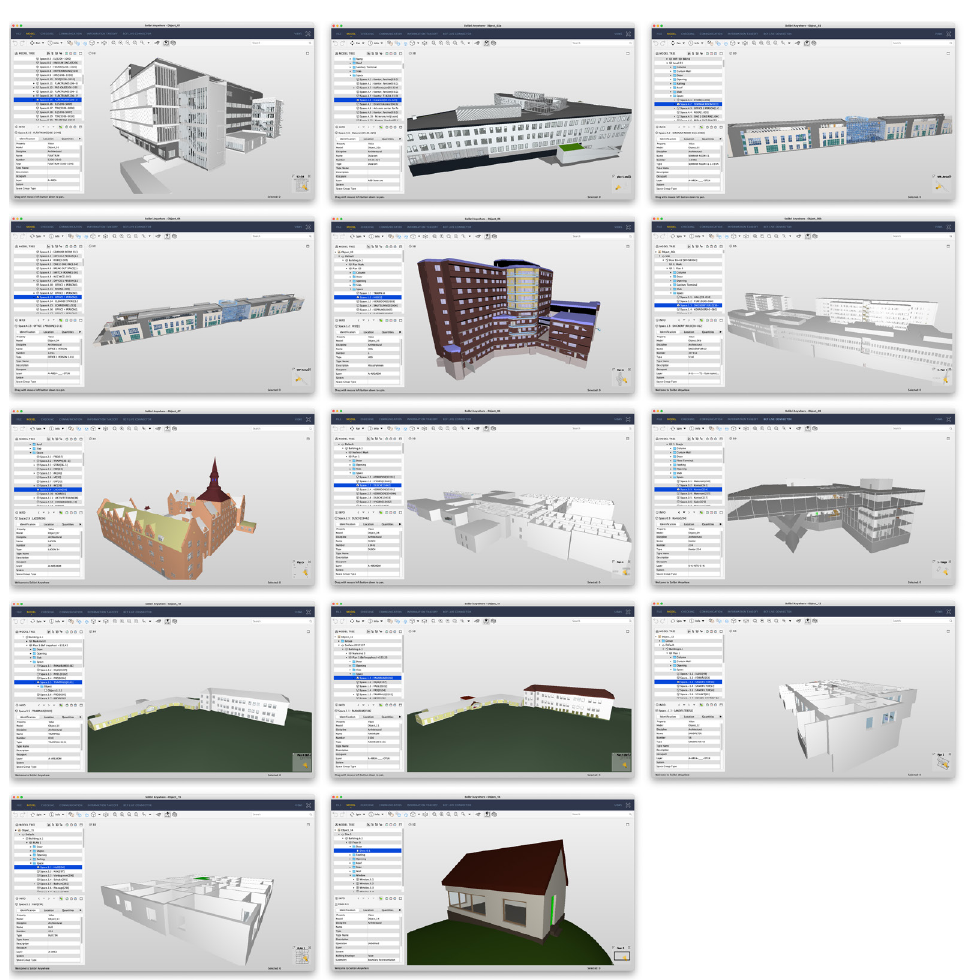
Fig. 1. Visualization of all models used in the test prepared in Solibri Anywhere. Top row left to right: Object_01, Object_02, Object_03; second row left to right: Object_04, Object_05, Object_06; third row left to right: Object_07, Object_08, Object_09; fourth row left to right: Object_10, Object_11, Object_12; last row left to right: